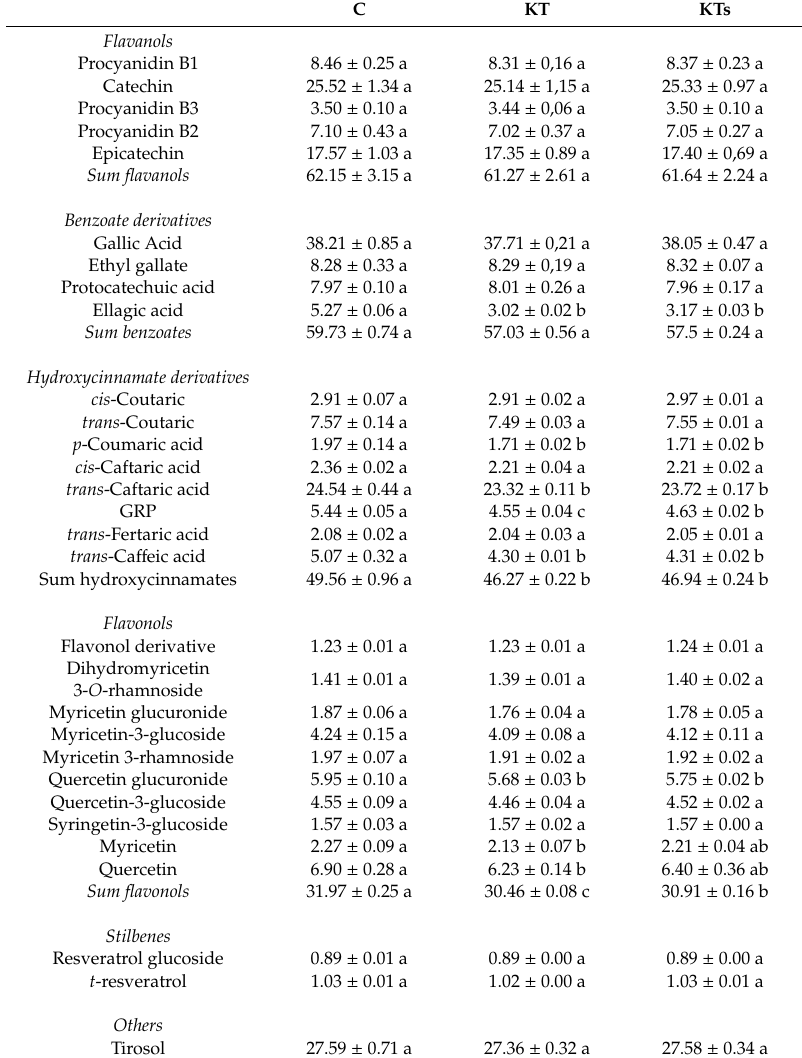
Table 2. Phenolic acids, flavonoids and other phenolics identified and quantified (mg / L) in red wines after 7 days of treatment. In the same row, di ff erent letters indicate significant di ff erences according to Tukey’s test ( p < 0.05). n = 3. C: no addition; KT: 0.5 g / L of solid chitosan; KTS: 0.5 g / L of chitosan in solution. GRP: grape reaction